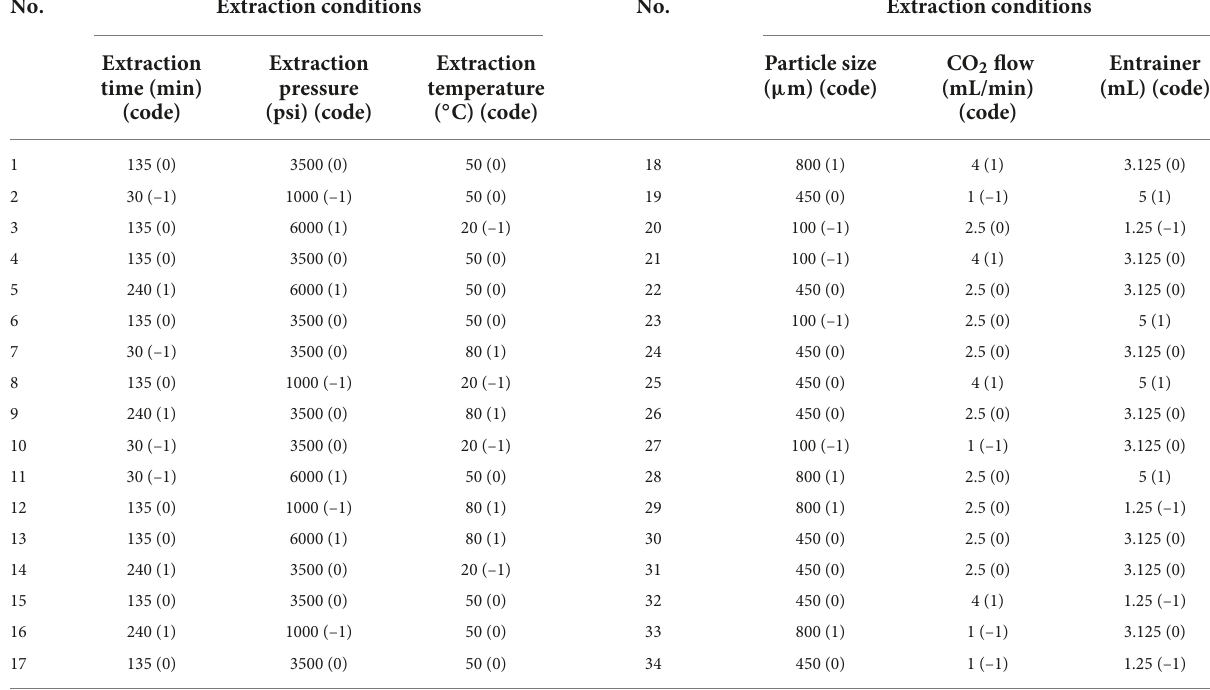
TABLE 1 Coded levels and actual values of the extract from Undaria pinnatifida stem under different conditions (extraction time, pressure, temperature, sample size, CO 2 flow, and entrainer) in the BBD.